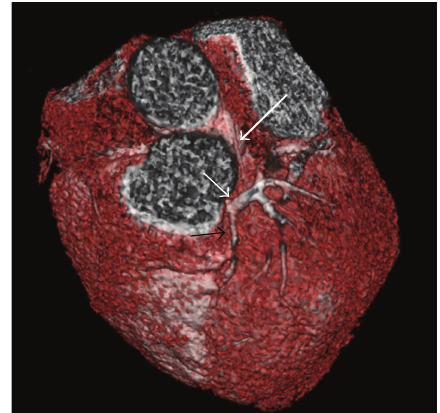
Figure 2: Short LADCA (hypoplastic) arising from the left sinus of Valsalva by CTA and selective coronary angiography.